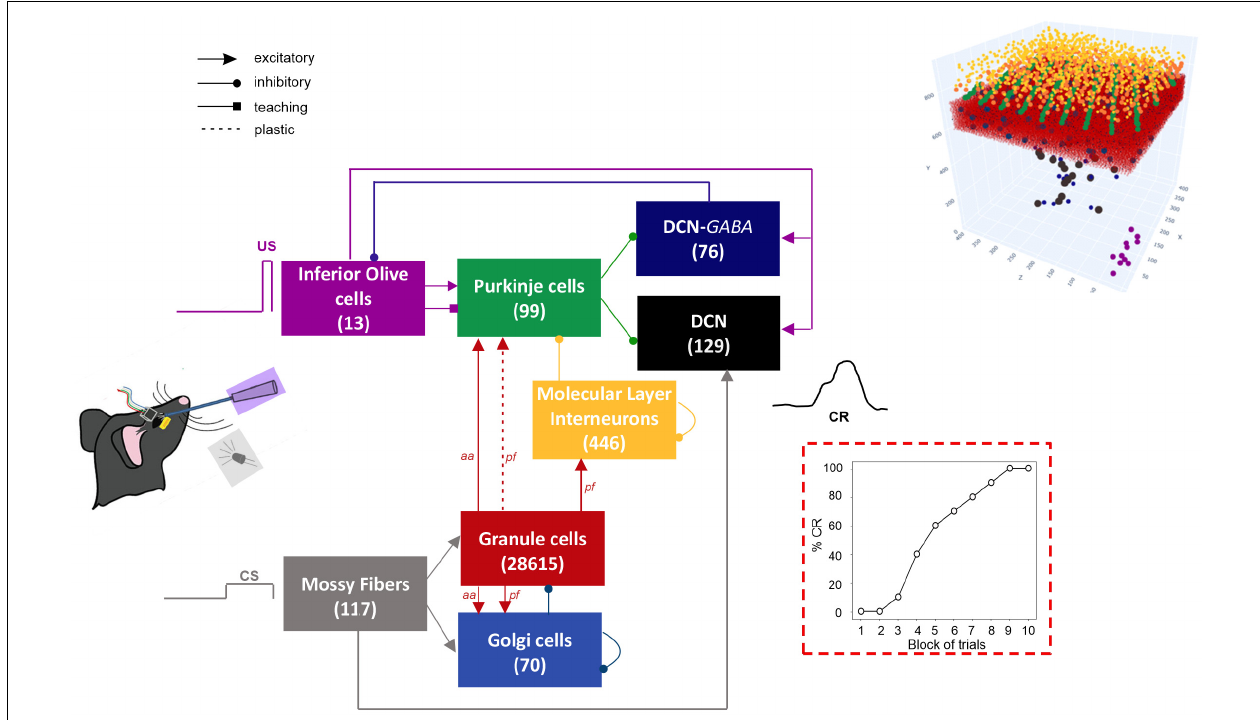
FIGURE 1 | Block diagram of the olivocerebellar SNN and the EBCC signals (CS; US; CR). On the right, the 3D network volume with the placed neurons is depicted (the Golgi cells are immersed in the granular layer). The number of cells is reported in each population box.